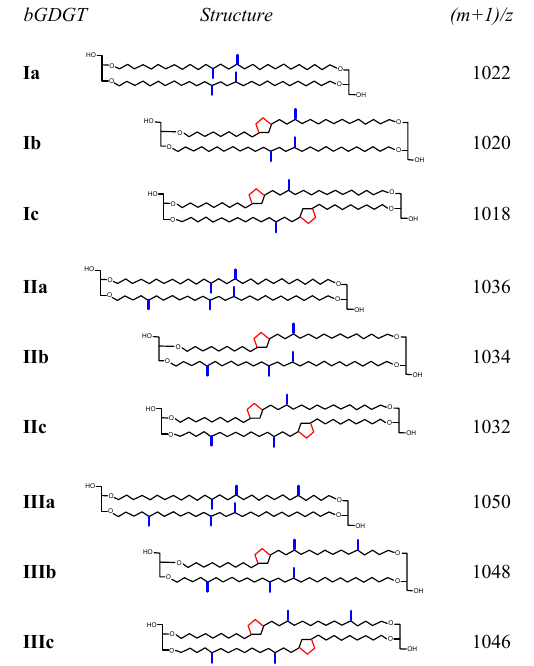
Figure 2. Molecular structures of bGDGTs and the mass to charge ratios of protonated molecular ions (after Weijers et al.,